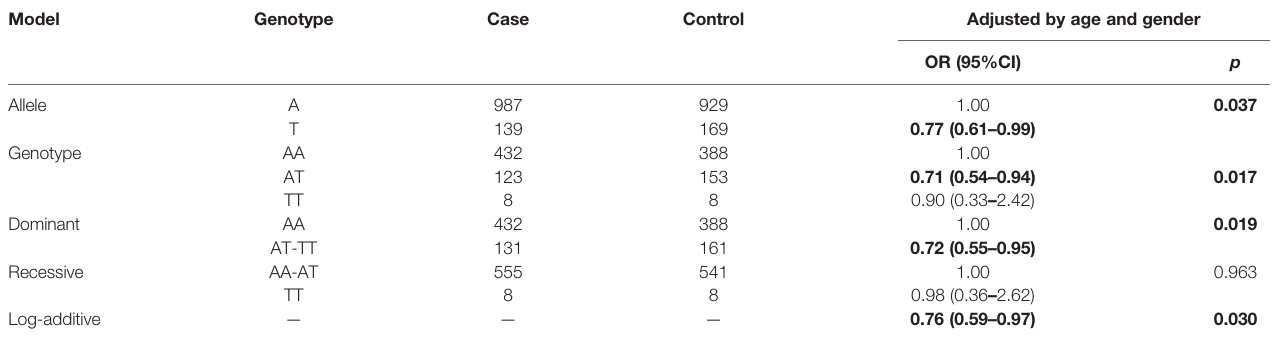
TABLE 2 | Relationships between LRRC3B rs1907168 polymorphism and breast cancer risk. Model